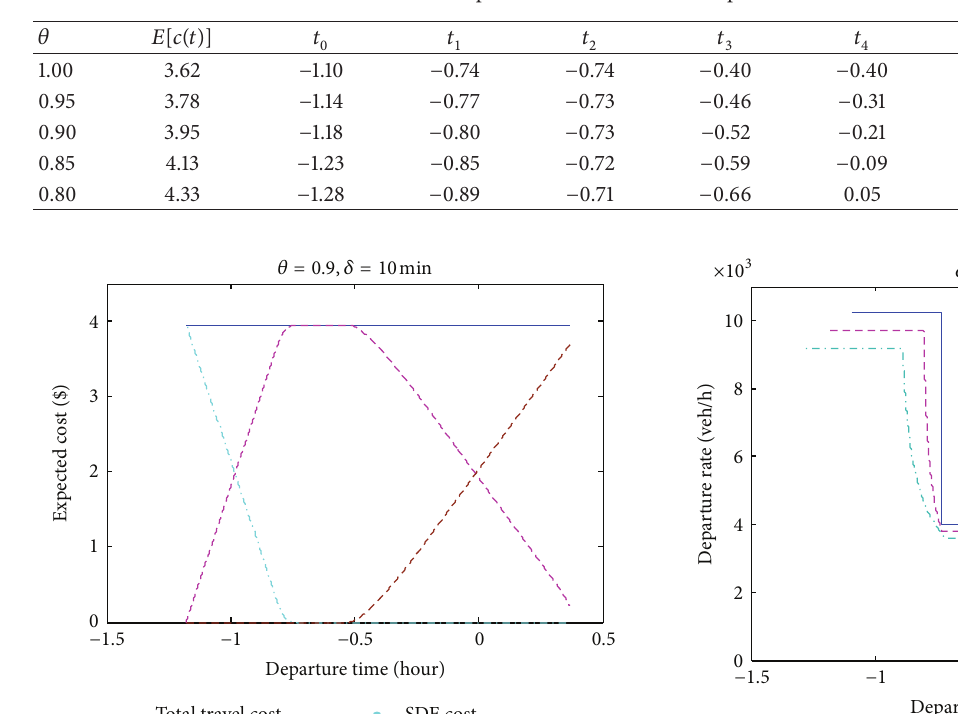
Table 1: The influence of parameter 𝜃 on the mean trip cost and the watershed time instant.